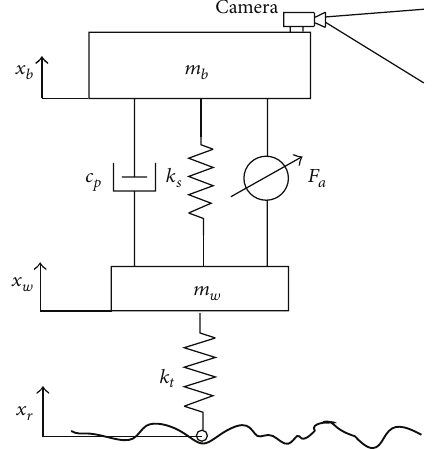
Figure 1: Quarter-car model with an active suspension.